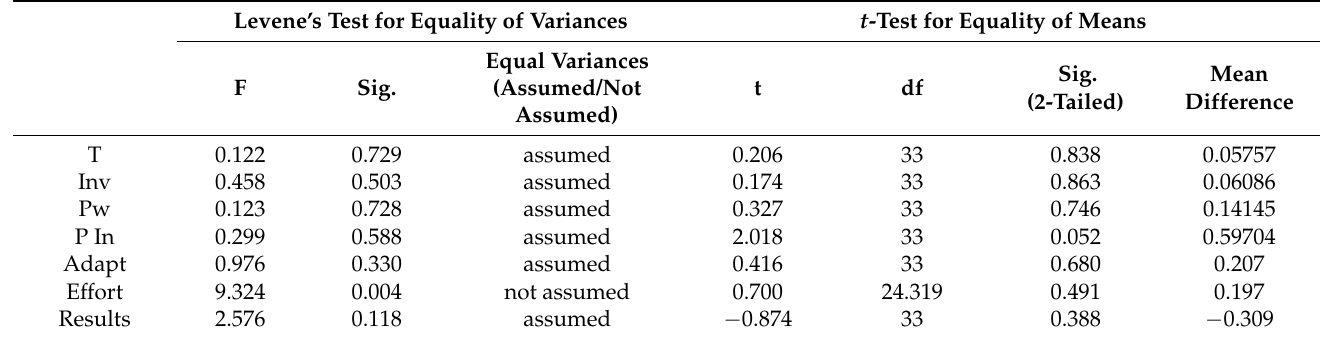
Table 11. Independent samples t-tests for teachers’